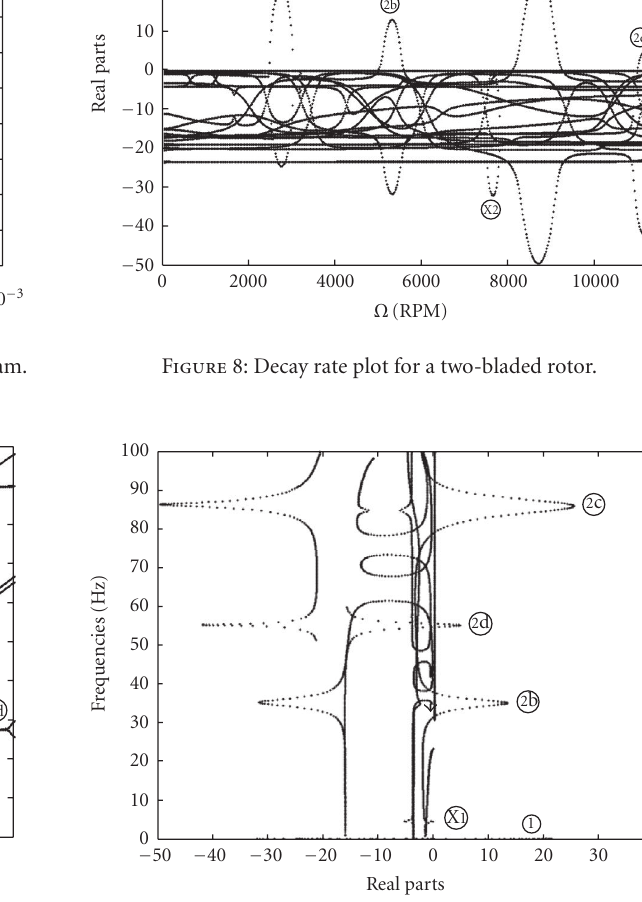
Figure 9: Complex plane diagram for a two-bladed